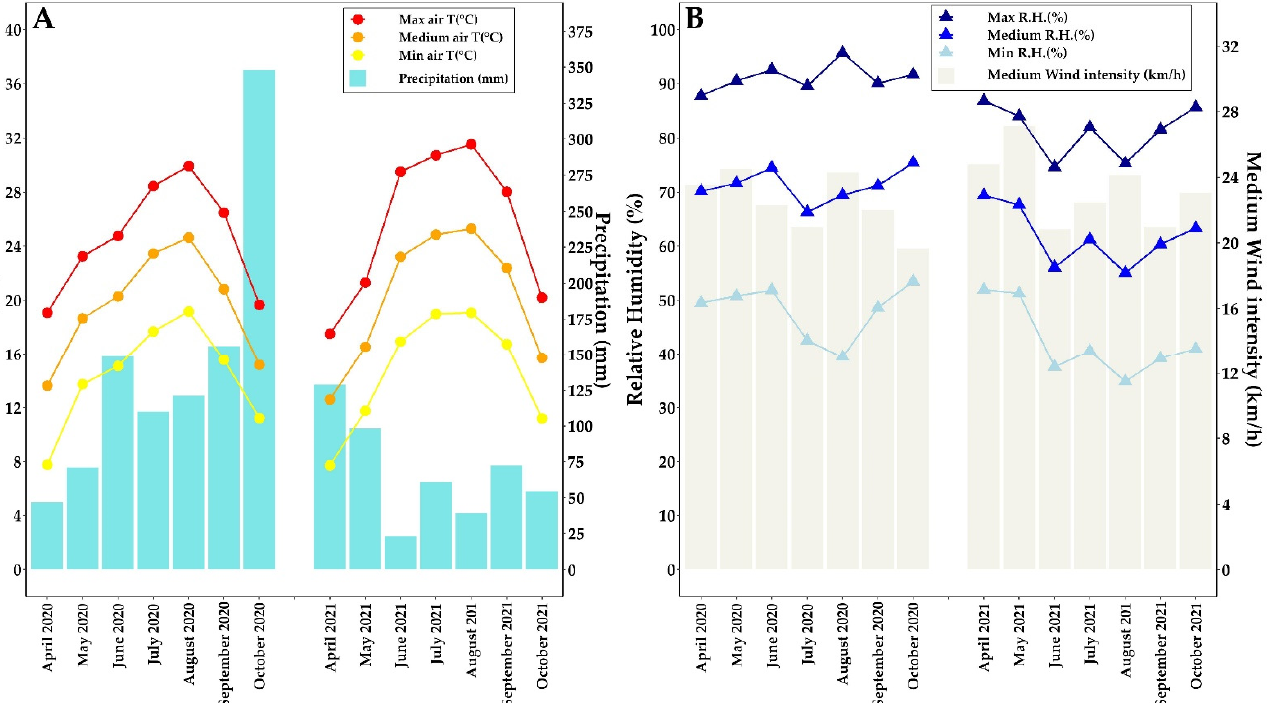
Figure 3. Meteorological conditions of the experiment location. Monthly averages of mean, maximum, minimum air temperature (°C), and summation monthly rainfall (mm) ( A ) were measured from April to October (2020–2021); monthly averages of mean, maximum, minimum relative humidity (%), and wind intensity (km/h) ( B ) were measured from April to October (2020–2021). Minimum, mean, maximum air temperatures, and minimum, mean, maximum relative humidity were measured in both seasons (April–October 2020–2021). The 2021 growing-production season demonstrated to be the hottest and less rainy during July and August. Max temperatures from June to August 2021 were higher than in the corresponding